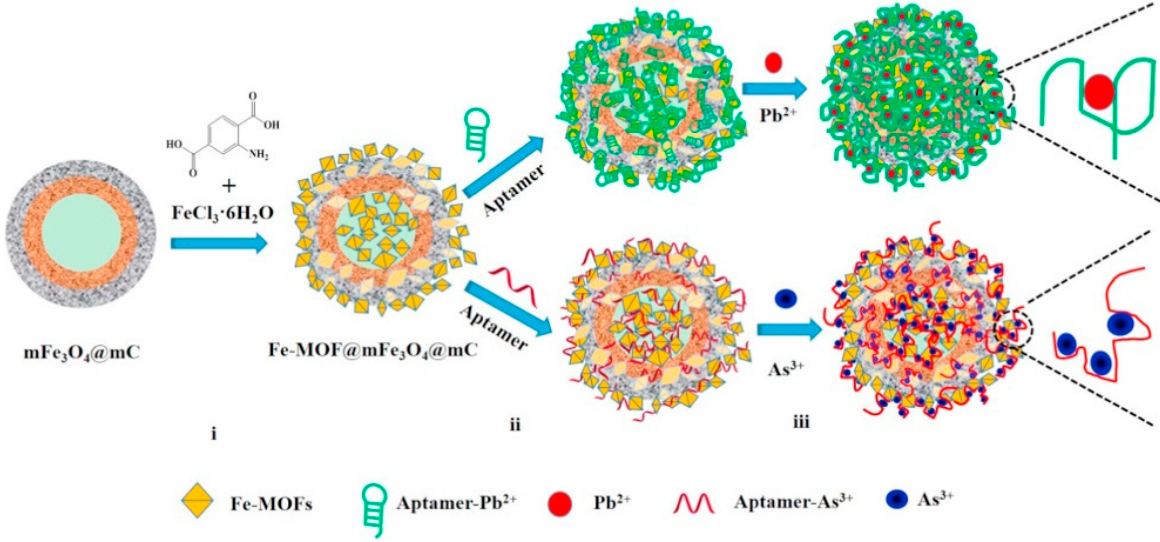
Figure 5. Preparation process for Fe-MOF@mFe 3 O 4 @mC nanocomposite and its related aptasensor for detection Pb 2 + and As 3 + via electrochemical techniques, including (i) the preparation of